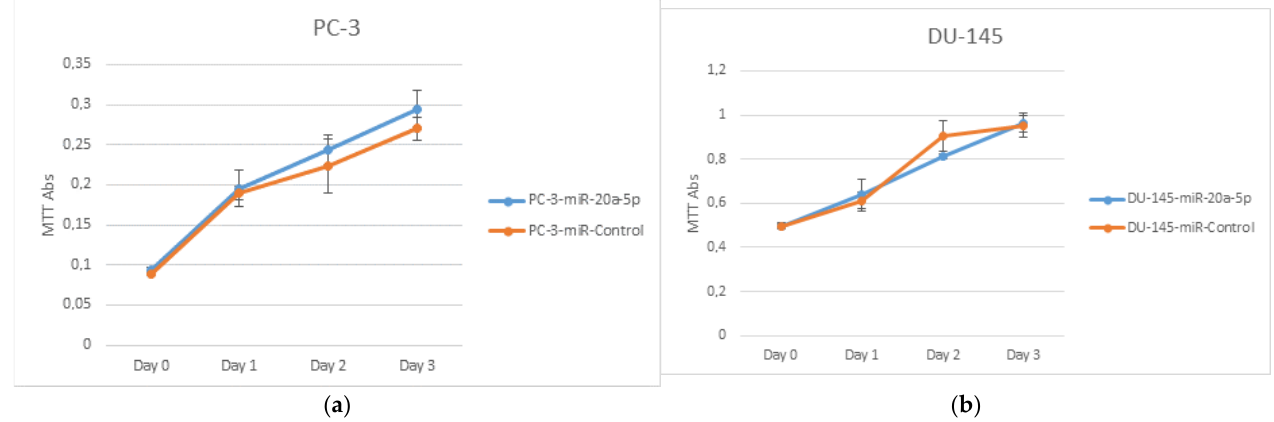
Figure 2. PC3 ( a ) and DU145 ( b ) cell lines were used to assess cell proliferation. PC3 and DU145 transfected with miR-20a-5p were compared to control cells. There were no significant differences in proliferation in PC3 or DU145 cell lines.